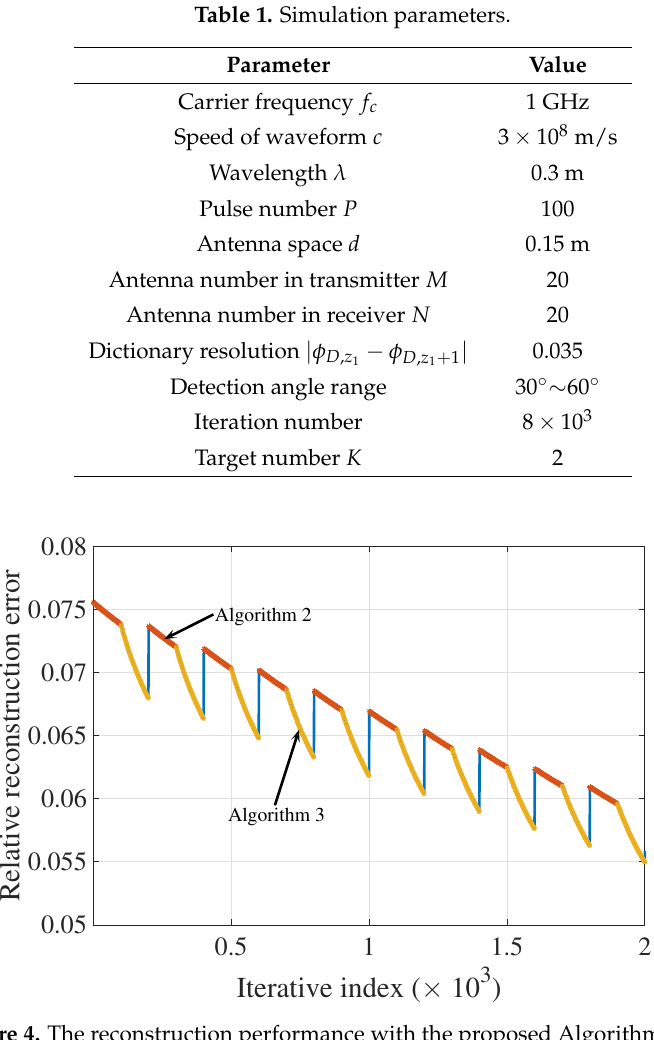
Figure 4. The reconstruction performance with the proposed Algorithms 2 and